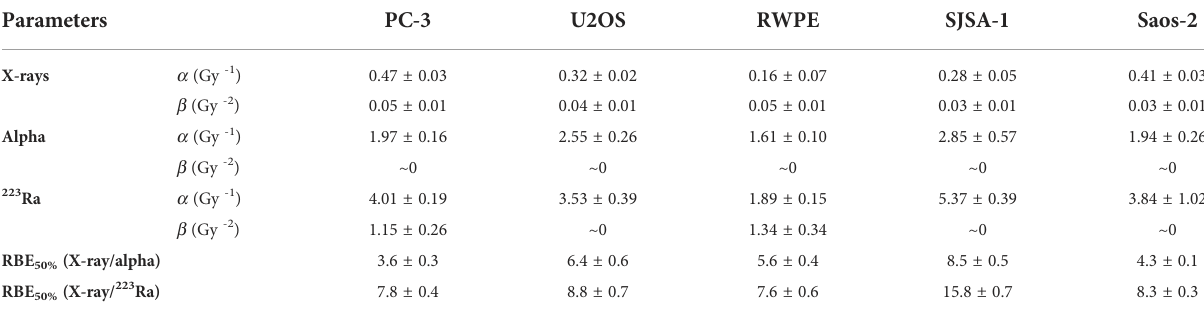
TABLE 2 Linear quadratic parameters for PC-3, U2OS, RWPE, SJSA-1, and Saos-2 after exposure to different radiation qualities. Parameters